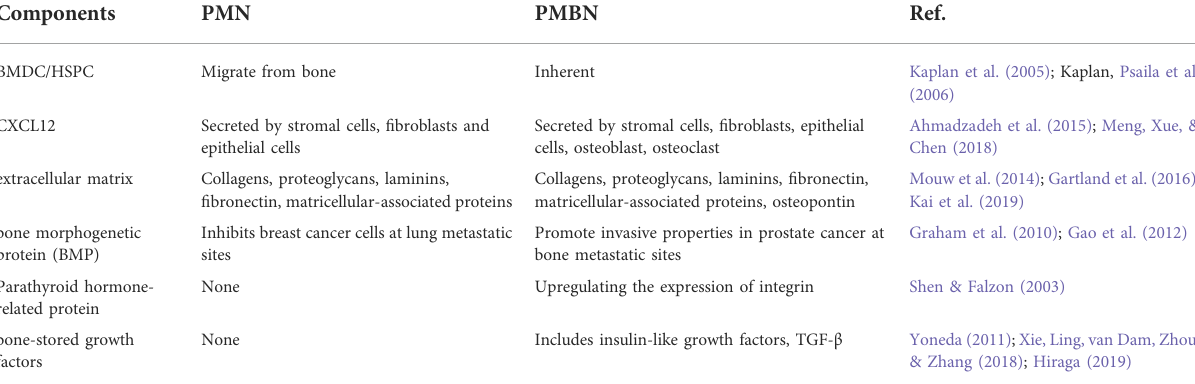
TABLE 1 The difference of source and function of components between PMN and PMBN.